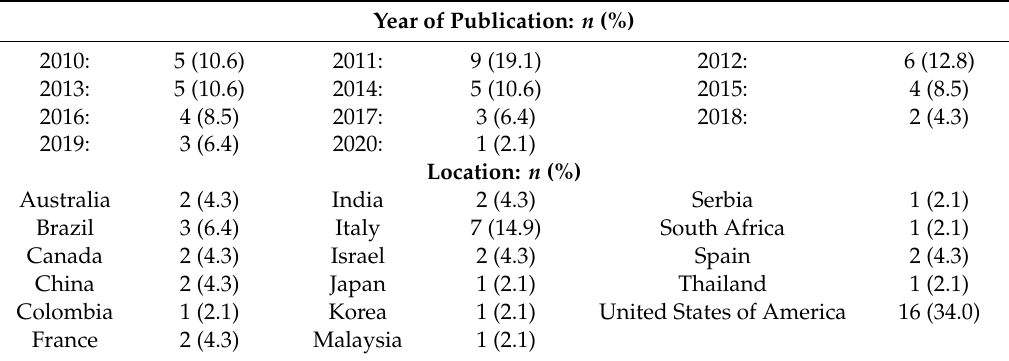
Table 1. Basic features of publications ( n =